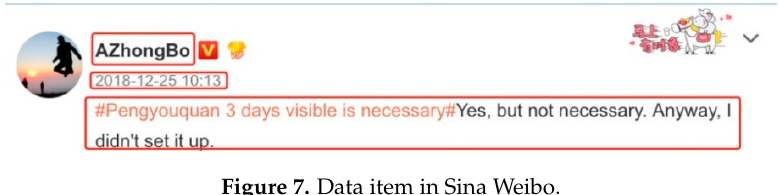
Figure 6. Data item in Tencent QQ Zone.